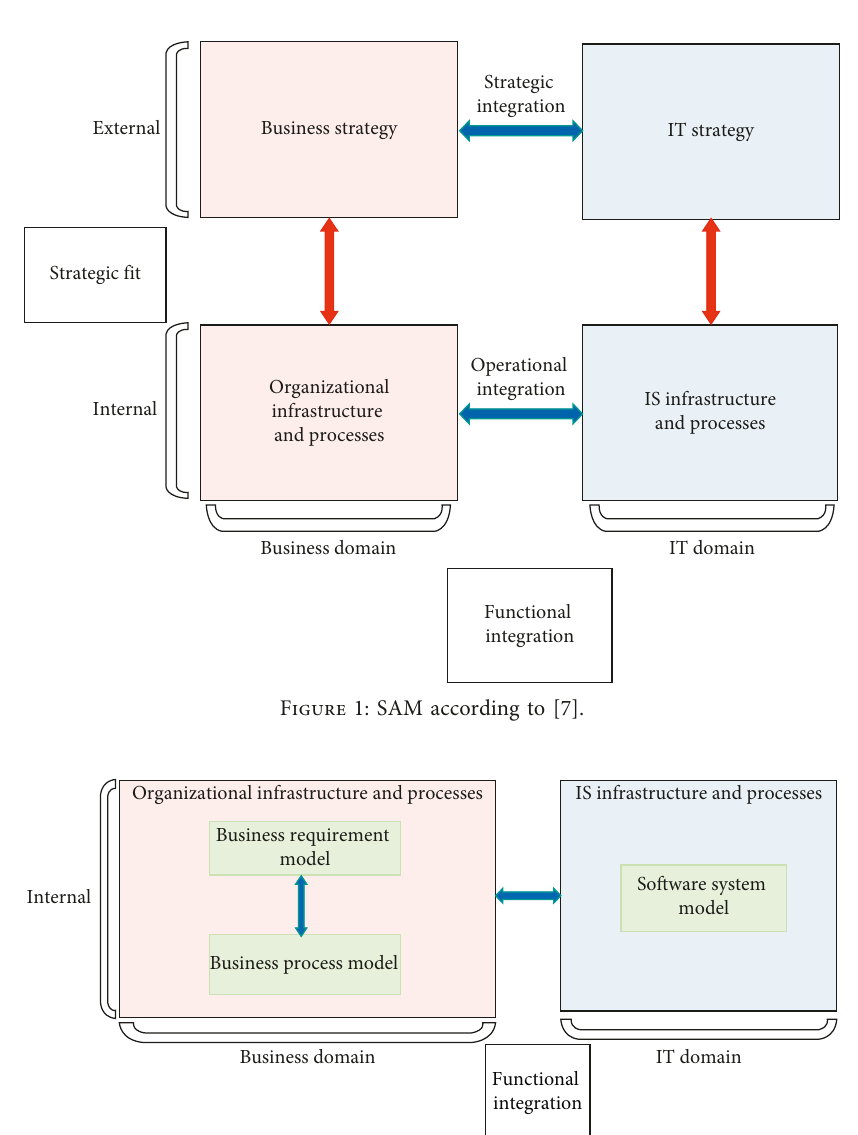
Figure 2: Elements of alignment positioned in the SAM.